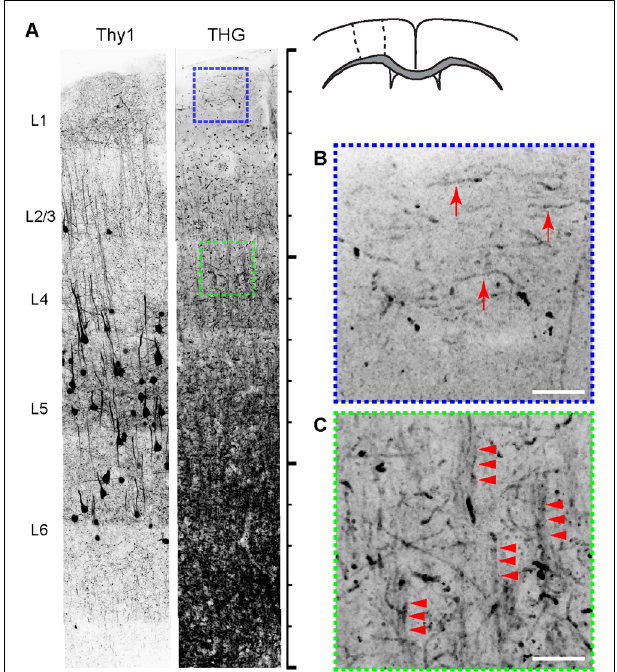
FIGURE 2 | The relationship between cyto- and myeloarchitecture of the cerebral cortex by Thy1-YFP and THG, respectively (inverted contrasts). (A) The coronal section. Scale bar, 1,500 µ m. (B,C) Magnified views of regions shown in (A) . THG images of layers 1 (blue) and 4 (green). Myelinated fibers tangential (arrows) and radial to the pia (arrowheads) appear in specific layers. Scale bar, 25 µ